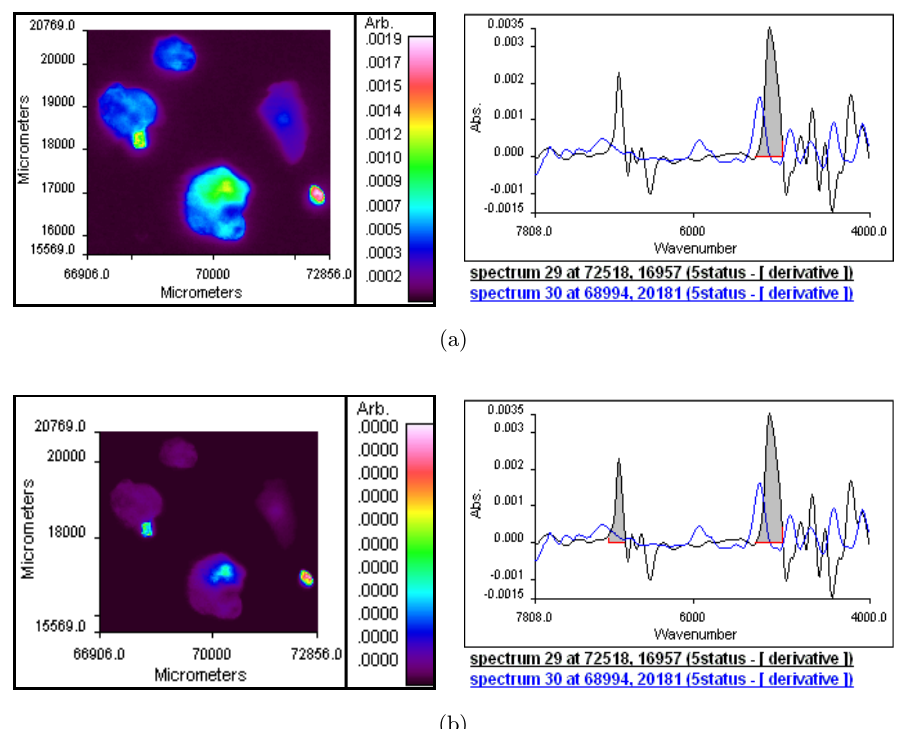
Fig. 5. Peak integration images with di®erent wavelength range. (a) First derivative (the area under 5300 – 5000 cm (cid:1) 1 without base points). (b) First derivative (the area under 6980 – 6780 cm (cid:1) 1 and 5300 – 5000 cm (cid:1) 1 without base points).